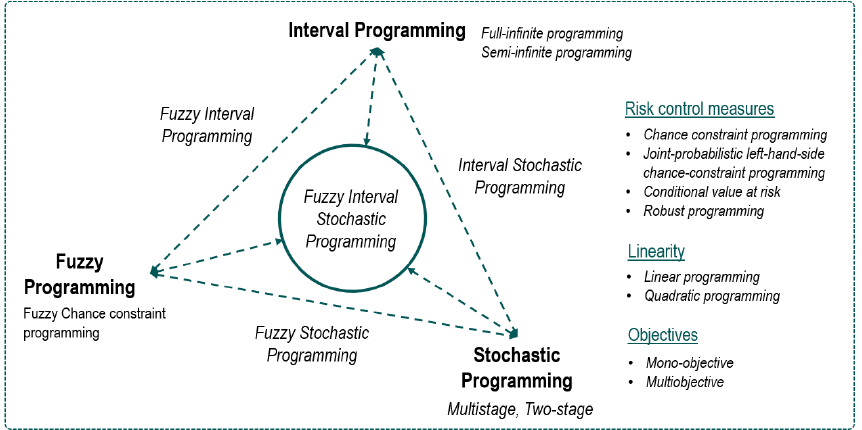
Figure 3. Main strategies related to